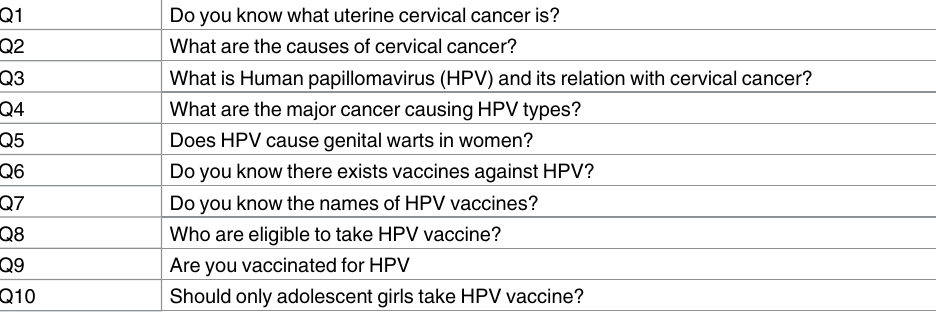
Table 1. Questionnaire employed for awareness about cervicalcancer and